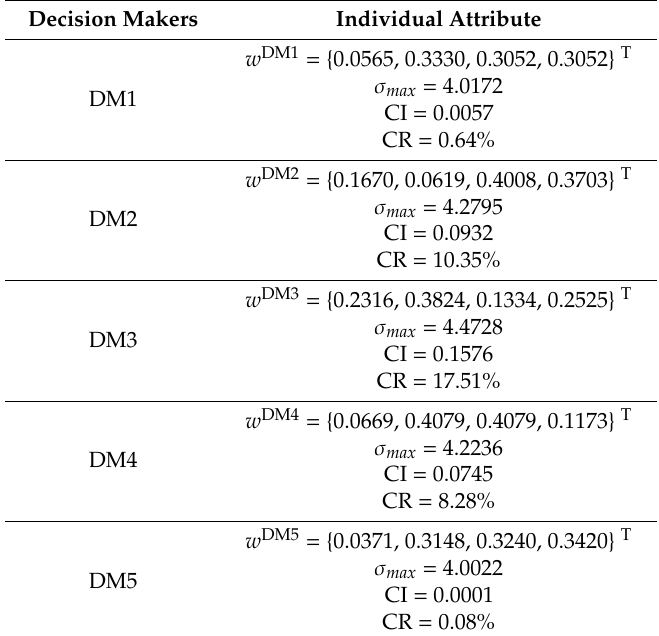
Table 7. Results on decision-makers’ attributes on strategic sub-element.